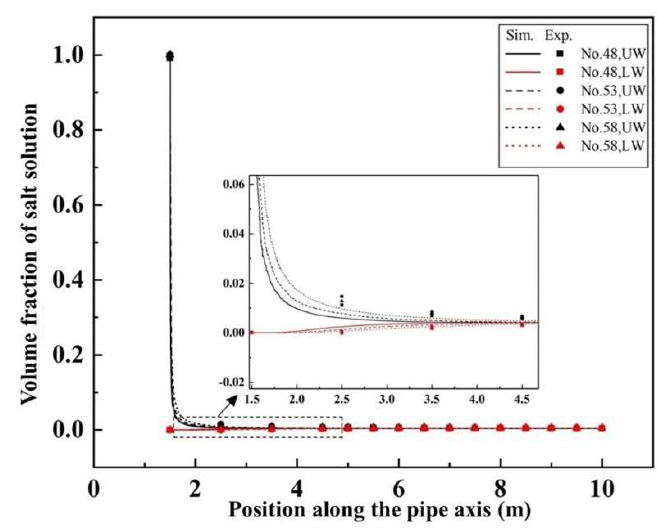
Figure 6. Comparison of experimental and simulation results for No. 48, No. 53, and No. 58.